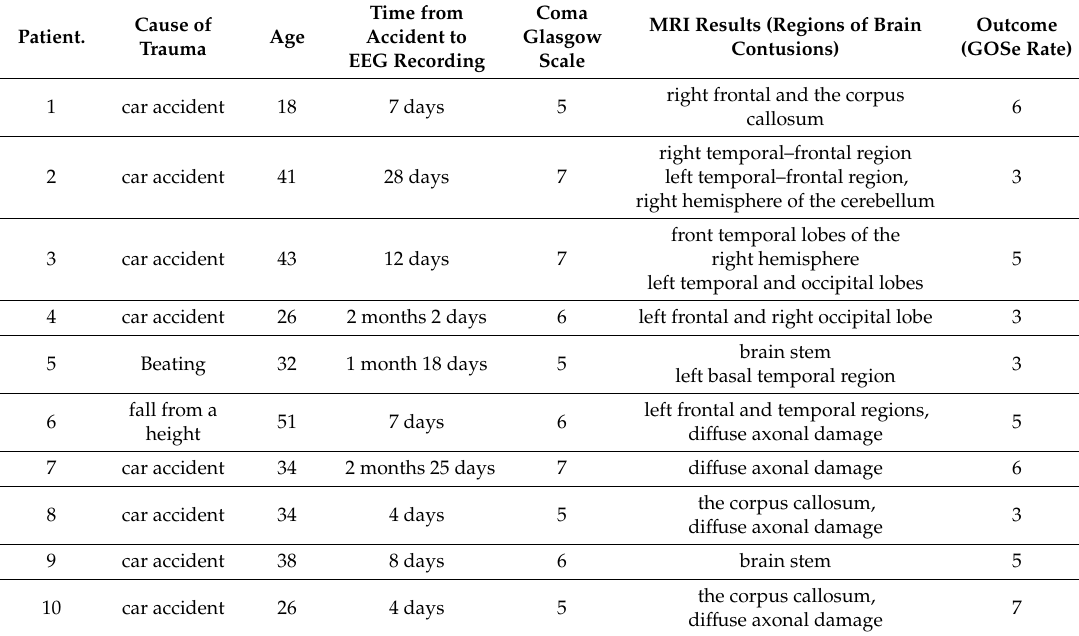
Table 1. Clinical information about